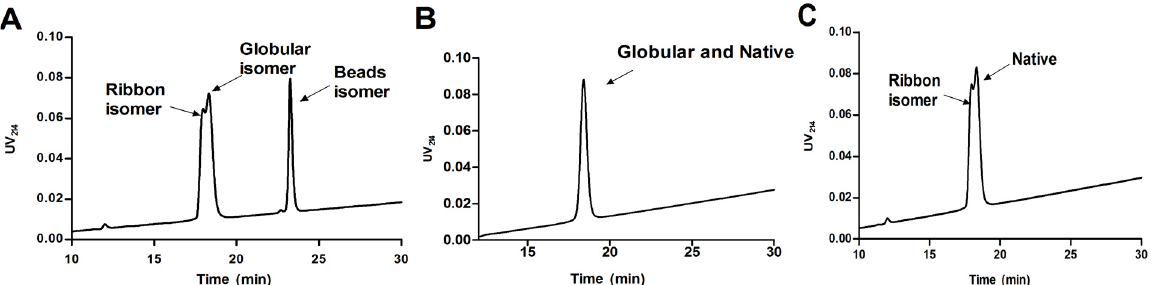
Figure 6. Air oxidation random folding of α -CTx TxIA linear peptide in 0.1 M NH